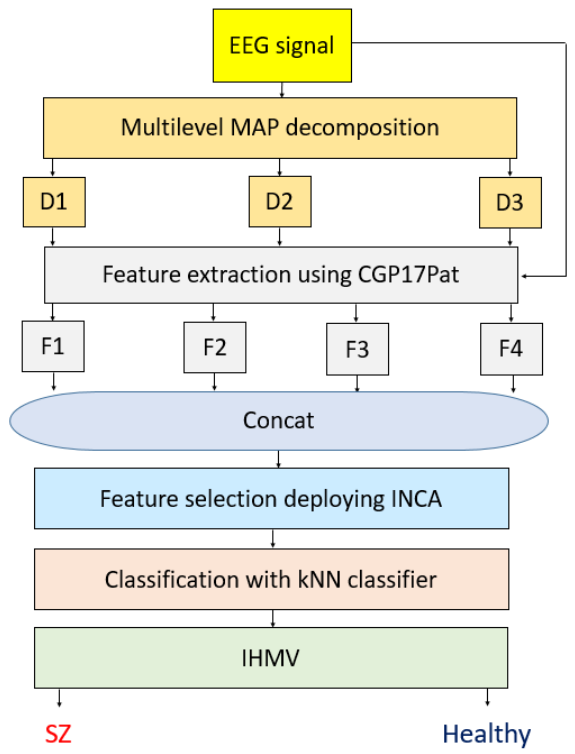
Figure 1. Schematic diagram of the proposed CGP17Pat-based schizophrenia detection model.